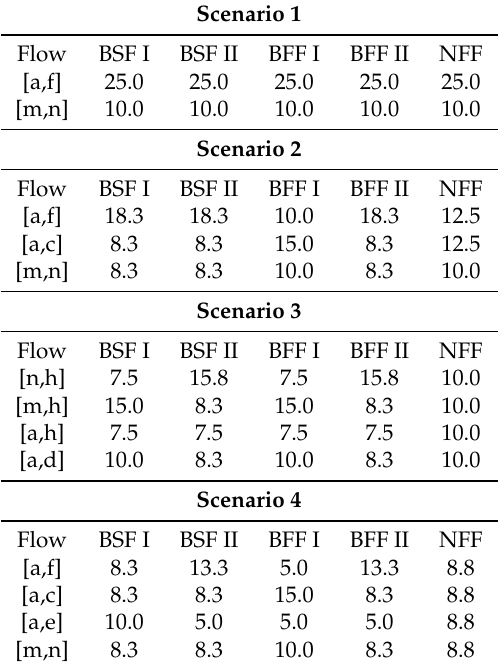
Table 2. Flow set and linear programming (LP) results for the flows’ end-to-end throughput for scenarios 1 to 4 described in Figure 13. All values in Mbps.